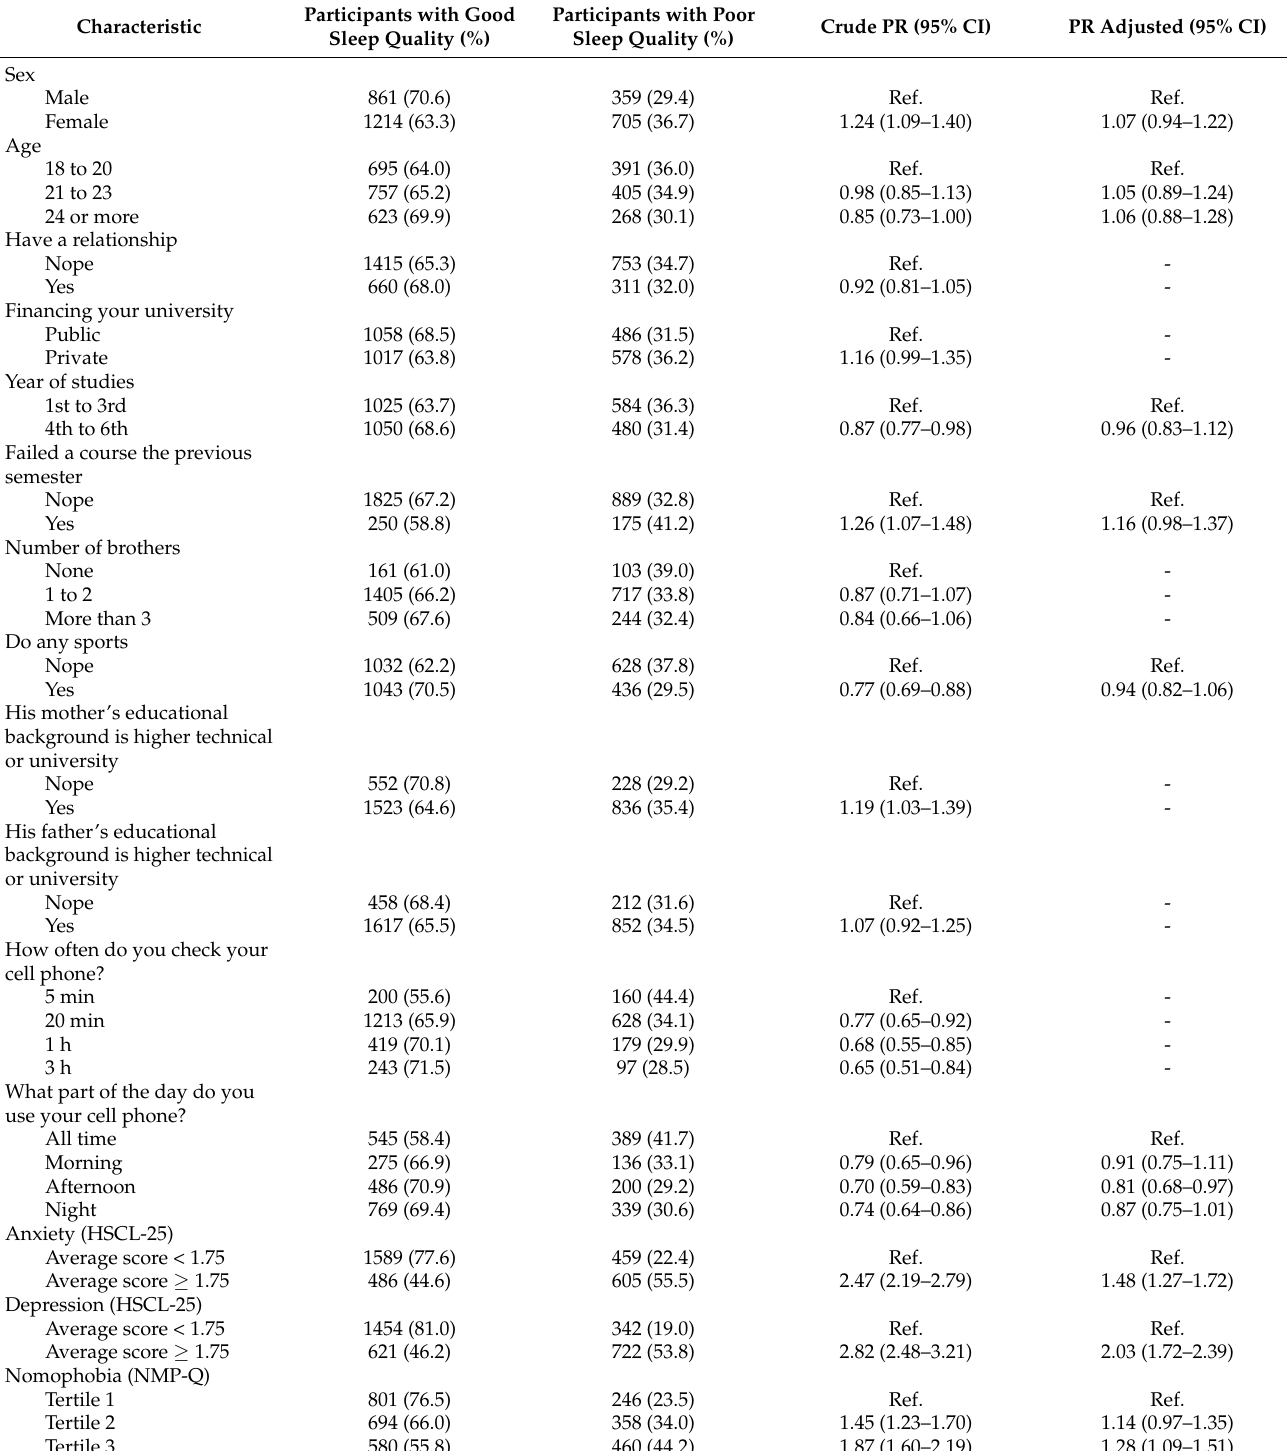
Table 3. Poisson regression to determine the factors associated with poor sleep quality in the study